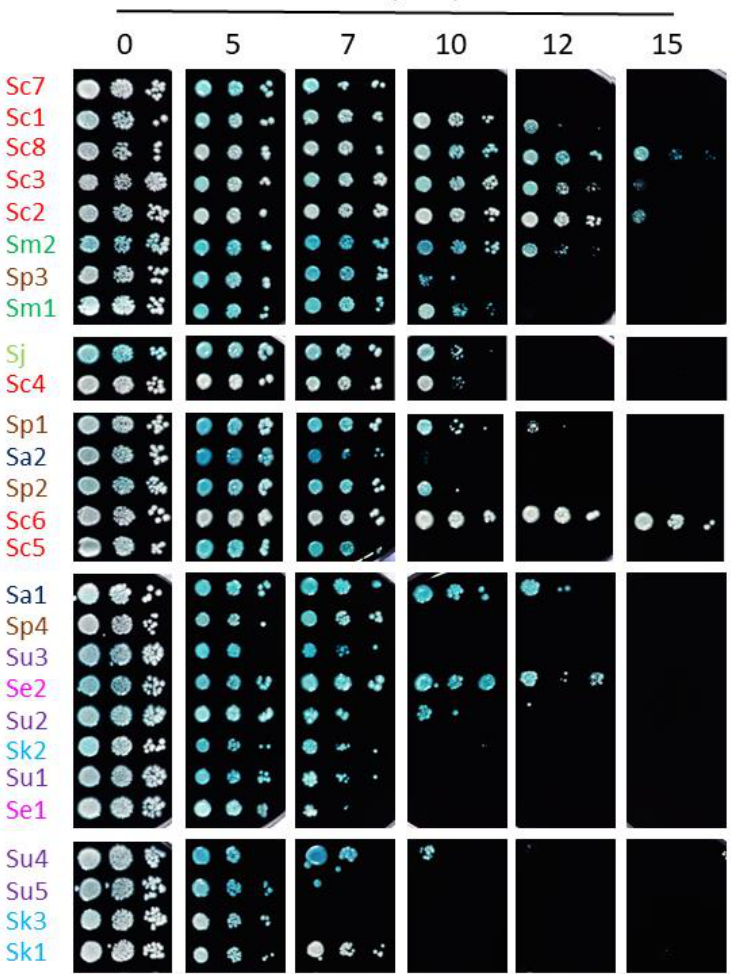
Figure 4. Growth of Saccharomyces strains in high-iron conditions. Overnight precultures were diluted to an OD 600 of 0.1, 0.01 and 0.001 and spotted on SC + 1 mM methylene blue agar plates with the indicated range of FAS concentrations. Plates were incubated for 7 days at 20 °C and then photographed. An intense blue color indicates a more oxidized state of the cells. Strains are sorted based on MIC values and species-specific colors are used as in the above figures.